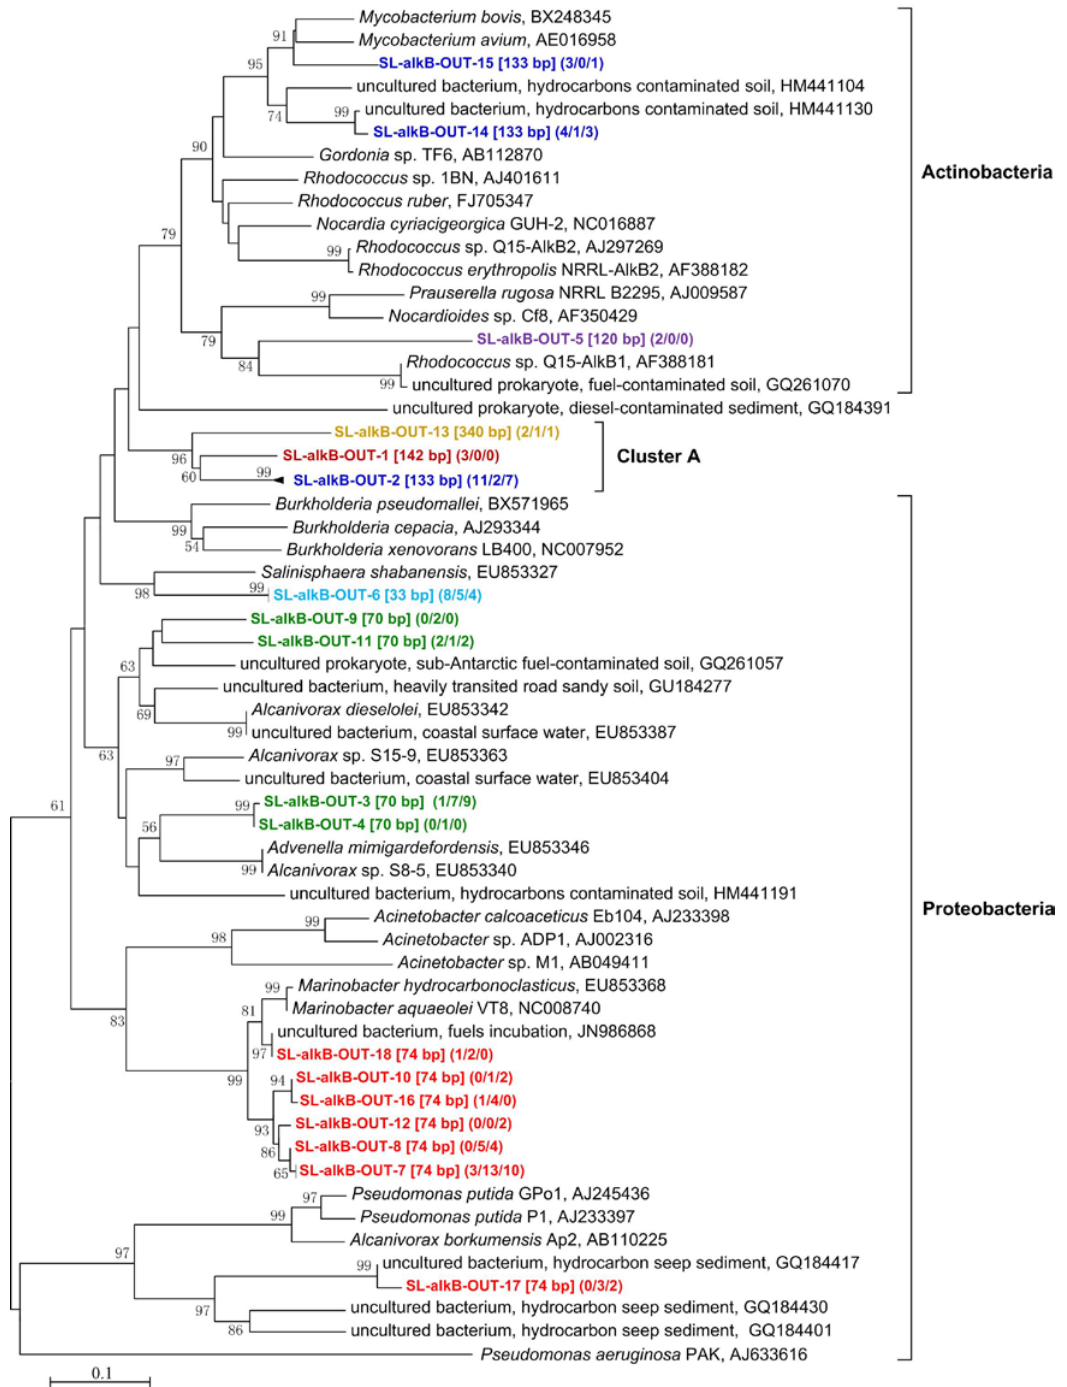
Fig. 2. Phylogenetic relationship of deduced alkB sequences (182 amino acids) generated from different soil samples. The scale bar represents 10% sequence divergence; values at the nodes are the percentages of 1000 bootstrap replicates supporting the branching order; bootstrap values below 50% are not shown. Representative clones obtained in this study are shown in different colors, which represent different n -alkane-degrading groups, and the in silico T-RF size is given in square brackets. A similarity cutoff of 97% is used to define an OTU (operational taxonomic unit). The number of clones for each representative OTU is given in parentheses (reference soil/oil field surface soil/gas field surface soil). Reference sequences are shown in black.